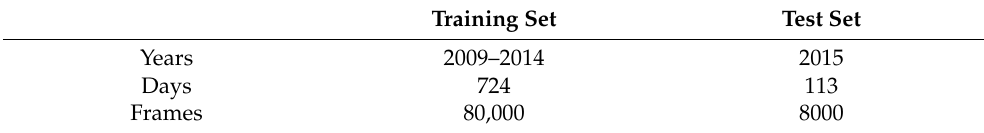
Table 7. The dataset used in the second stage.